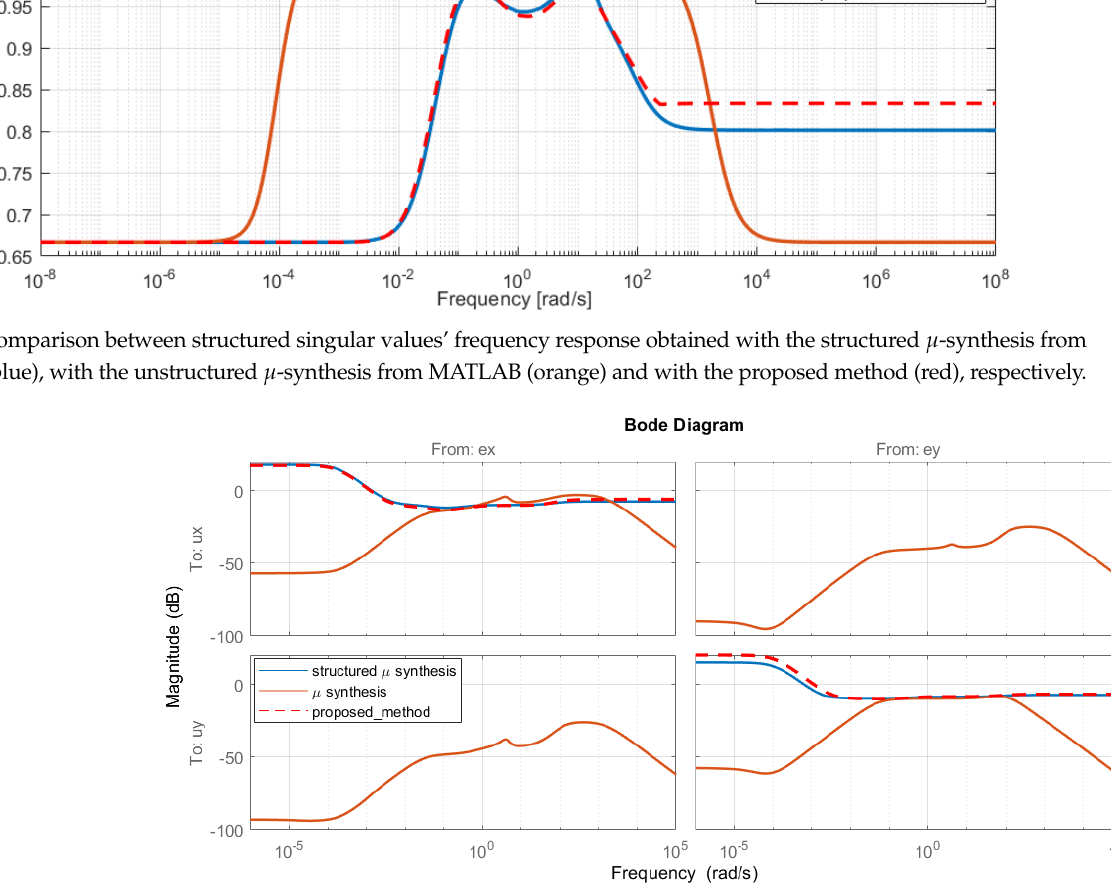
Figure 8. Obtained controllers’ frequency responses with the structured µ -synthesis from MATLAB (blue), unstructured (orange) µ -synthesis from MATLAB, and with the proposed method